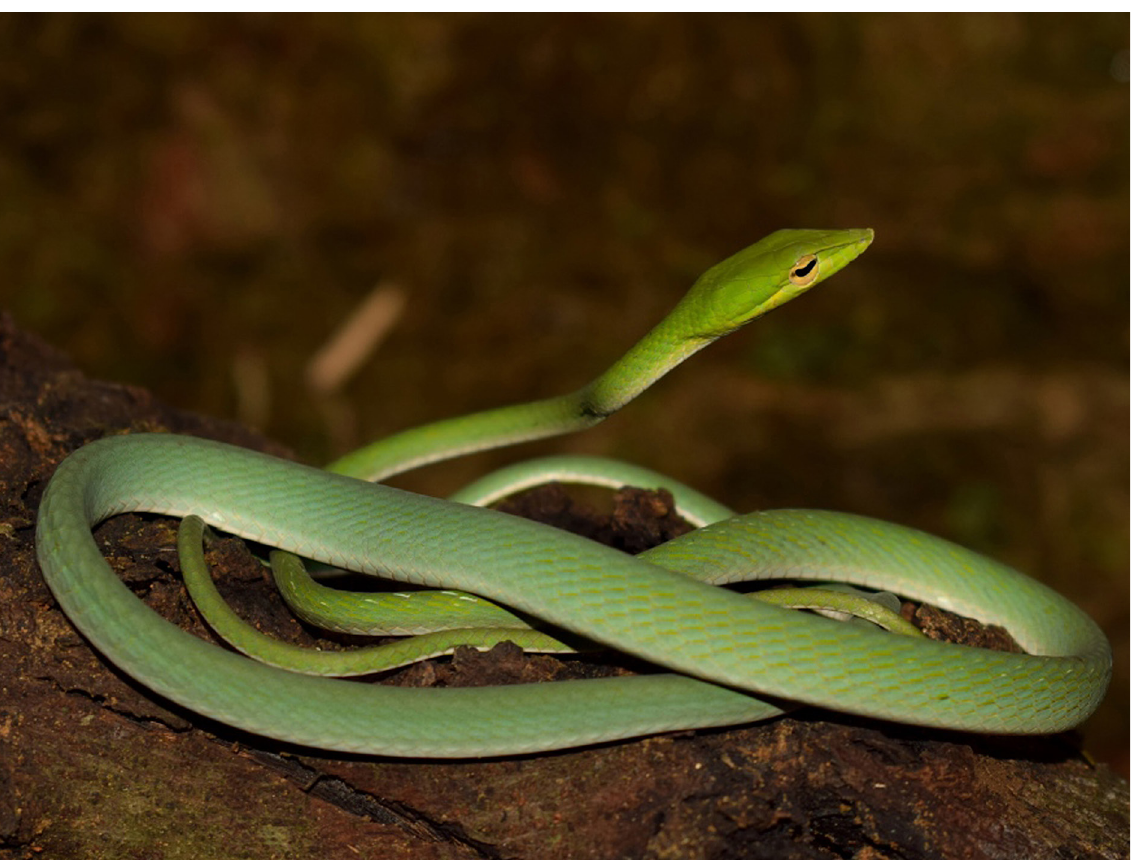
Fig. 8. Ahaetulla flavescens (Wall, 1910) comb. nov. Live uncollected specimen from Mizoram, showing the usual green colouration which is dominant in this species. Photo: Ajay